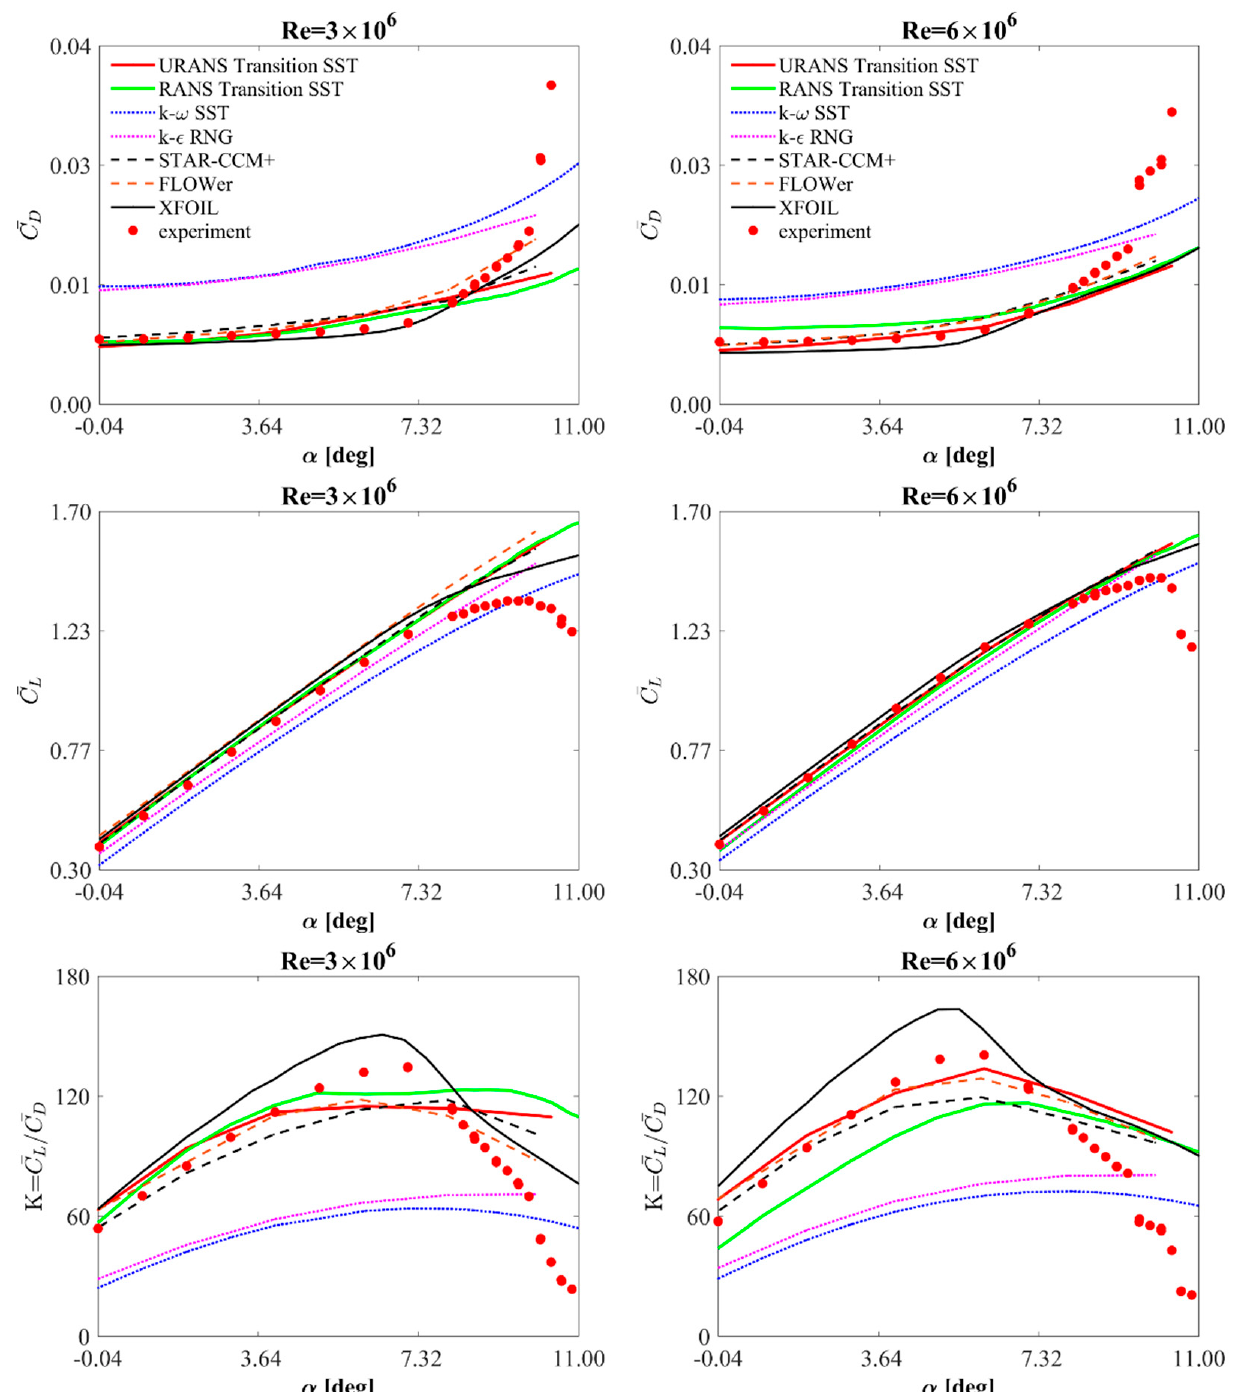
Figure 5. DU-91-W2-250 airfoil performance for two Reynolds numbers of 3 × 10 (cid:2874) and 6 × 10 (cid:2874) . 𝑑𝛼⁄ was 6.88 for a Reyn- For experimental data, the aerodynamic derivative 𝑎 = 𝑑𝐶 (cid:3013) olds number of 3 × 10 (cid:2874) and 7.08 for a Reynold numbers of 6 × 10 (cid:2874) . These derivatives are estimated for angles of attack in the range from 0 ° to 8.1 ° . For the same angles of attack range, the RANS approach together with the Transition SST turbulence model provided the aerodynamic derivatives of 7.03 and 6.95 for Reynolds numbers of 3 × 10 (cid:2874) and 6 × 10 (cid:2874) , respectively. Values of the relative error of the aerodynamic derivative are 2.25%